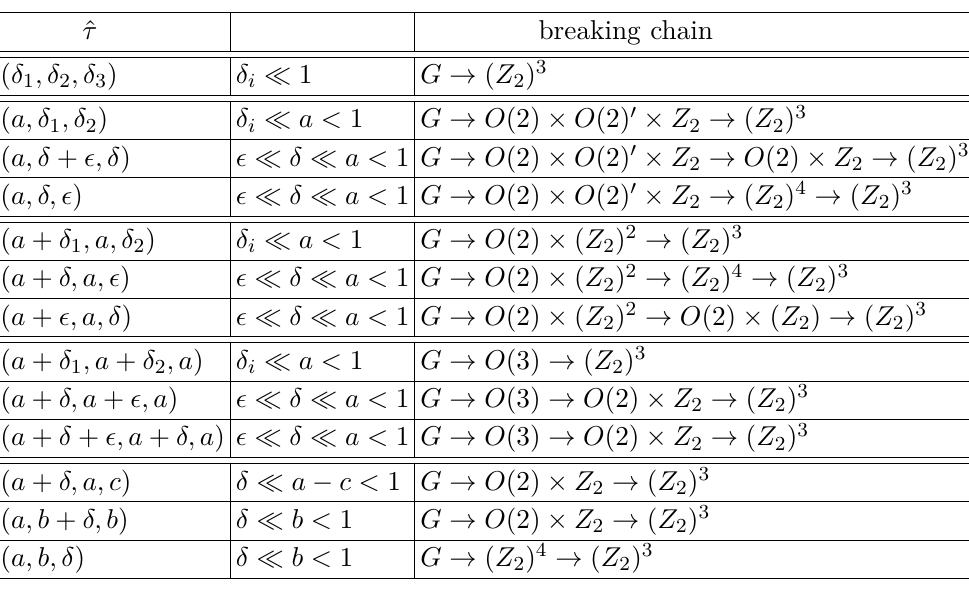
Table 6 . Possible breaking chains of the group G = O (3) × O (3) acting on a (3 , 3) representation, described by 3 × 3 real matrices τ